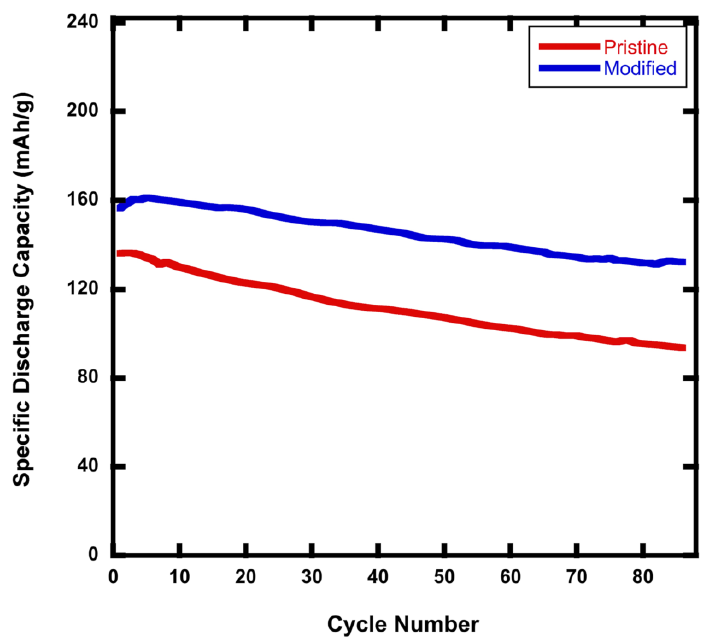
Figure 4. The pristine NMC811 battery has ∼ 69% capacity retention, whereas the rGO modified battery has ∼ 85% capacity retention after 88 cycles over the voltage window of 2.5 V–4.5 V at 2C. An additive amount of 5wt% rGO was used in the rGO/NMC811 battery.